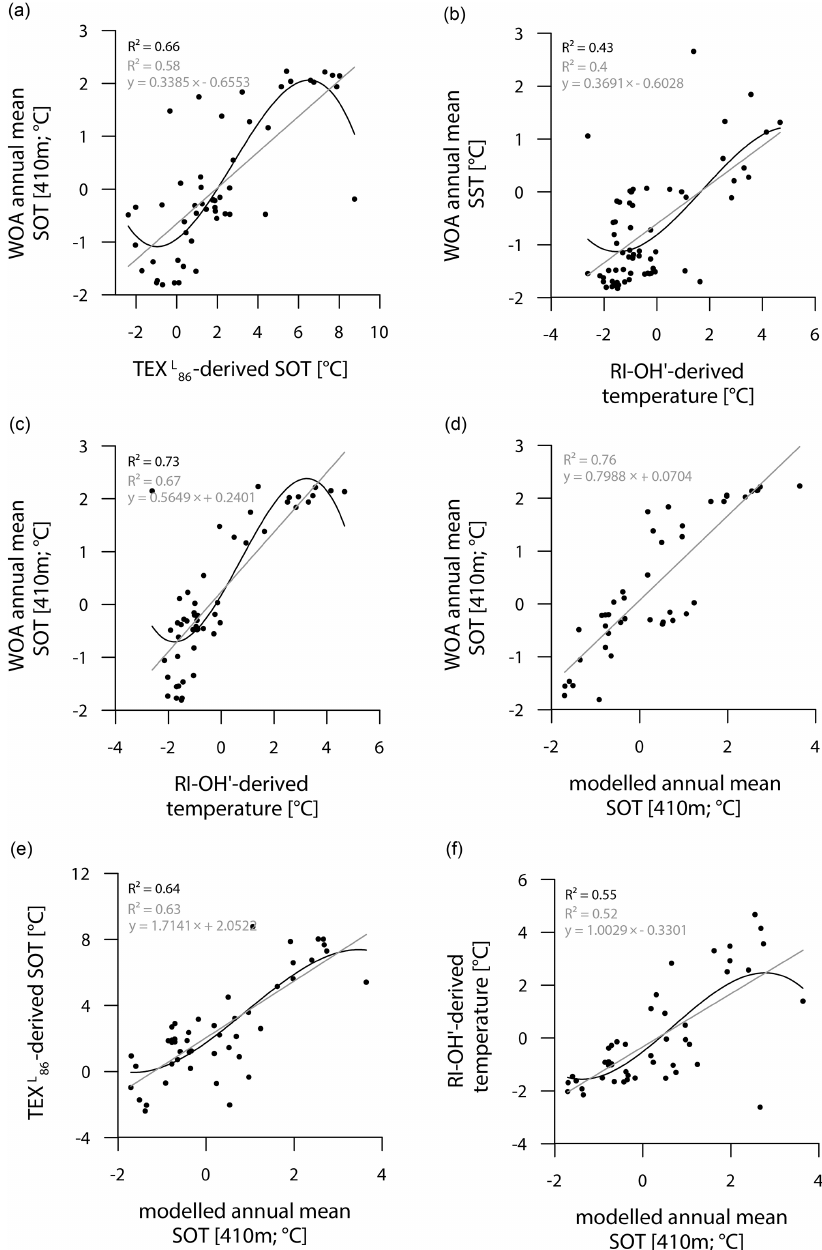
-derived SOT, (b) WOA annual mean SST vs. RI-OH (cid:48) -derived Figure 7. Correlations of (a) WOA annual mean SOT (410m) vs. TEX L 86 temperature, (c) WOA annual mean SOT (410m) vs. RI-OH (cid:48) -derived temperature, (d) WOA annual mean SOT (410m) vs. modelled annual mean SOT (410m), (e) TEX L -derived SOT vs. modelled annual mean SOT (410m) and (f) RI-OH (cid:48) -derived temperature vs. modelled annual 86 mean SOT (410m) in degrees Celsius. Coefficients of determination ( R 2 ) are given for the respective regression